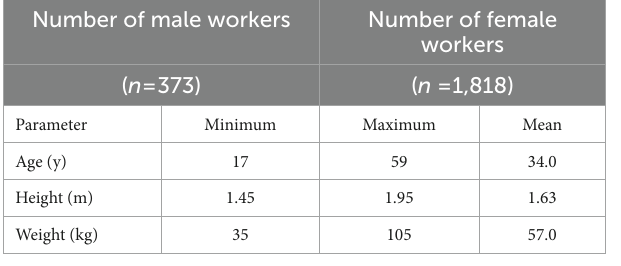
TABLE 2 Anthropometric data of the study participants.